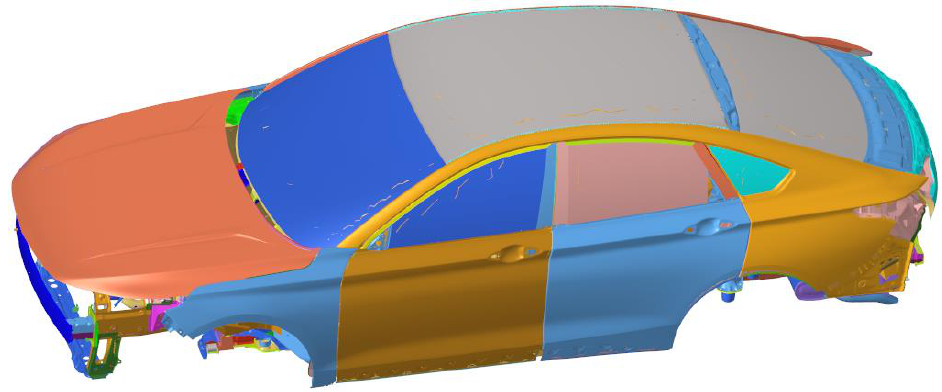
Figure 7. TB finite element model.